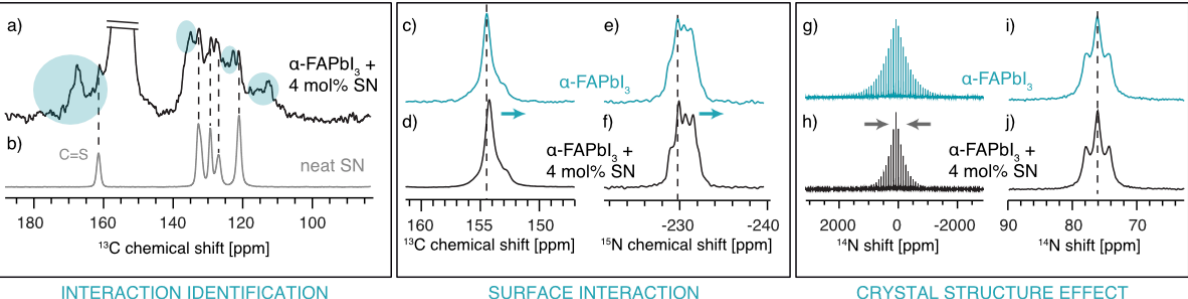
Figure 10. Probing molecular modulation at the atomic level by solid-state NMR spectroscopy. (a−b) Identifying interactions via 13 C cross-polarization (CP) solid-state magic angle spinning (MAS) NMR spectra at 11.7 T, 105 K, 10 kHz MAS of a) neat mechanochemi- cal α- FAPbI 3 with 4 mol% SN and b) neat SN. Blue circles showcase the new environments that are associated with the interaction of the modulator. (c–f) Minor changes in the chemical shift (0.2 ppm) highlighted by the blue arrows of the 13 C CP and 15 N CP solid-state MAS NMR spectra at 11.7 T, 105 K, 10 kHz MAS of neat mechanochemical c,d) α- FAPbI 3 and e,f) α- FAPbI 3 with 4 mol% SN suggest that the interaction takes place on the surface of the hybrid perovskite as opposed to by A-cation incorporation. (g–j) Changes in the crystal struc- ture of FAPbI 3 revealed by 14 N solid-state MAS NMR spectra at 11.7 T, 298 K and g,h) 3 kHz and i,j) 20 kHz MAS of bulk mechanochemi- cal g) α- FAPbI 3 and h) α- FAPbI 3 with 4 mol% SN implied by narrowing of the SBB manifold (grey arrows). Panels i,j) shows the views of the center band. Adapted from ref.